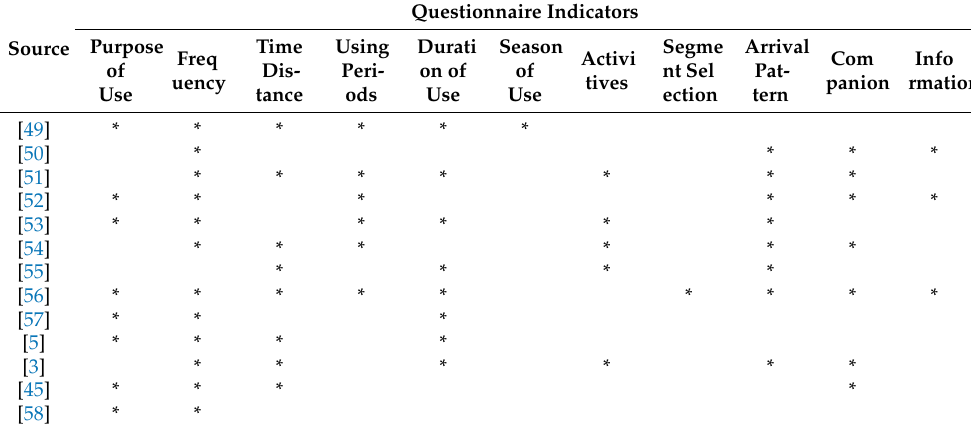
Table 1. Reference indicators of socio ‐ economic attributes.